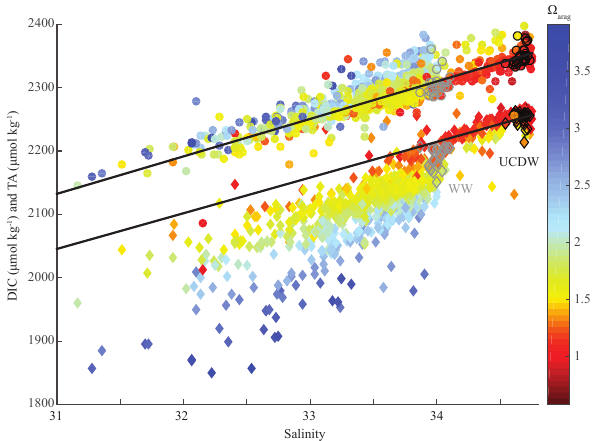
Figure 6. Salinity-normalized total alkalinity (sTA, µmolkg − 1 ) as a function of salinity-normalized dissolved inorganic carbon (sDIC, µmolkg − 1 ) for waters shallower than the Upper Circumpolar Deep Water (UCDW, orange circles). A linear fit between sTA and sDIC is shown by the black solid line. The dotted black lines indicate 2 σ for estimated measurement precision of σ = ± 5µmolkg − 1 . The blue line illustrates the trend if sTA and sDIC of the winter wa- ter (WW) were only influenced by photosynthesis (1 : − 6 . 2). Grey dots represent sTA as a function of sDIC corrected for gas ex- change in the waters above the WW, and the linear fits with the estimated measurement precision are the grey solid and dashed lines respectively. WW: T ≤− 1.2 ◦ C, 33.85 ≤ S ≤ 34.13; UCDW: 1.7 ◦ C ≥ T ≤ 2.13 ◦ C, 34.54 ≤ S ≤ 34.75, following (Martinson et al.,